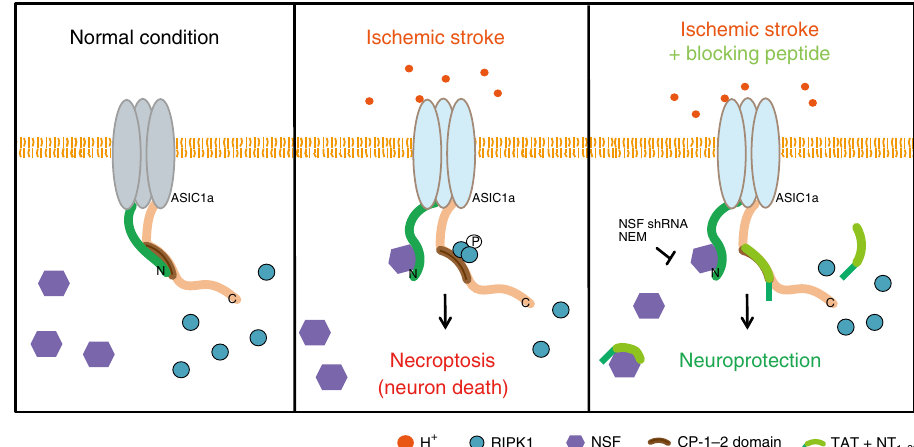
Fig. 7 Schematic diagram of proposed mechanism underlying conformational signaling of ASIC1a in acidotoxicity. Under normal conditions, the CP-1 death motif of ASIC1a-CT is masked by interaction with ASIC1a-NT (left). Acidosis activates ASIC1a and causes conformational transition that disrupts the preformed N- to C-terminal interaction within ASIC1a to unmask the CT death motif. This transition is facilitated and stabilized by NSF binding to ASIC1a- NT. The freed ASIC1a-CT recruits RIPK1 and activates it by phosphorylation, resulting in neuronal necroptosis (middle). Peptide NT 1 – 20 binds to ASIC1a-CT to prevent recruitment and thereby activation of RIPK1 to achieve neuroprotection (right). NT 1 – 20 may also bind to NSF, decreasing its availability for ASIC1a-NT, similar to NSF shRNA knockdown or inhibition by